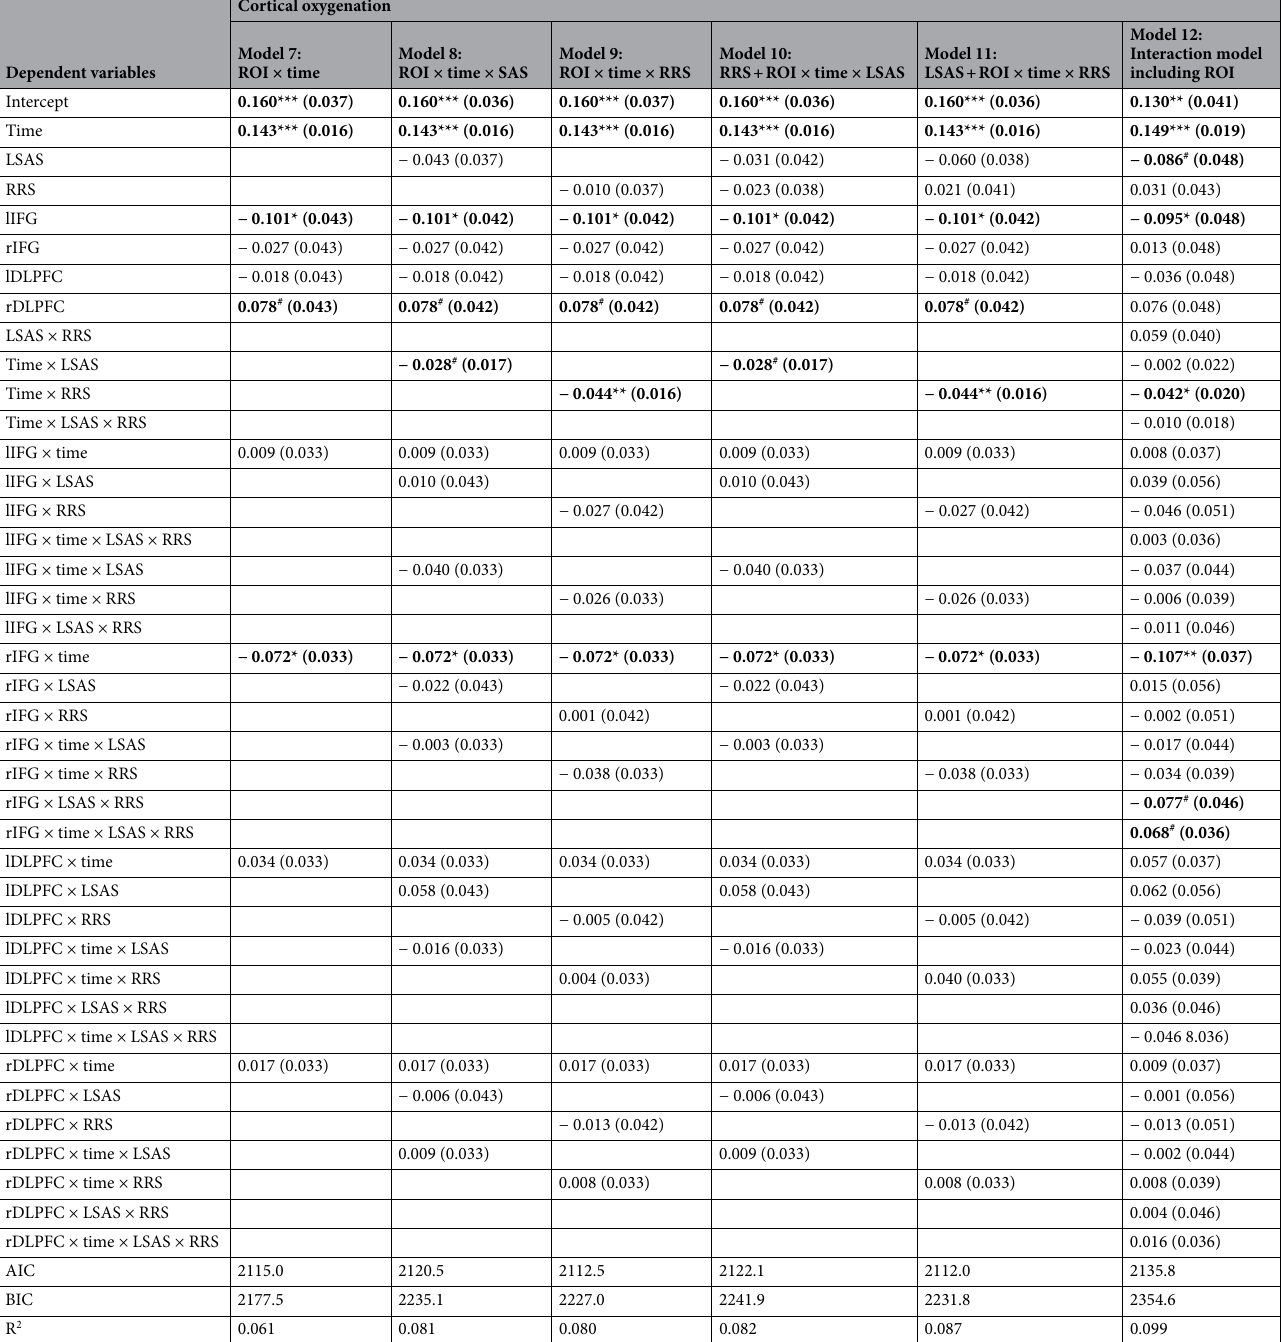
Table 3. Results of the Mixed Models exploring the association between cortical oxygenation in the different ROIs, social anxiety (LSAS) and trait rumination (RRS) ( AIC Akaike Information Criterion, BIC Bayesian- Information-Criterion, R 2 variance explained by the fixed effects). Significant results are bold. # p <